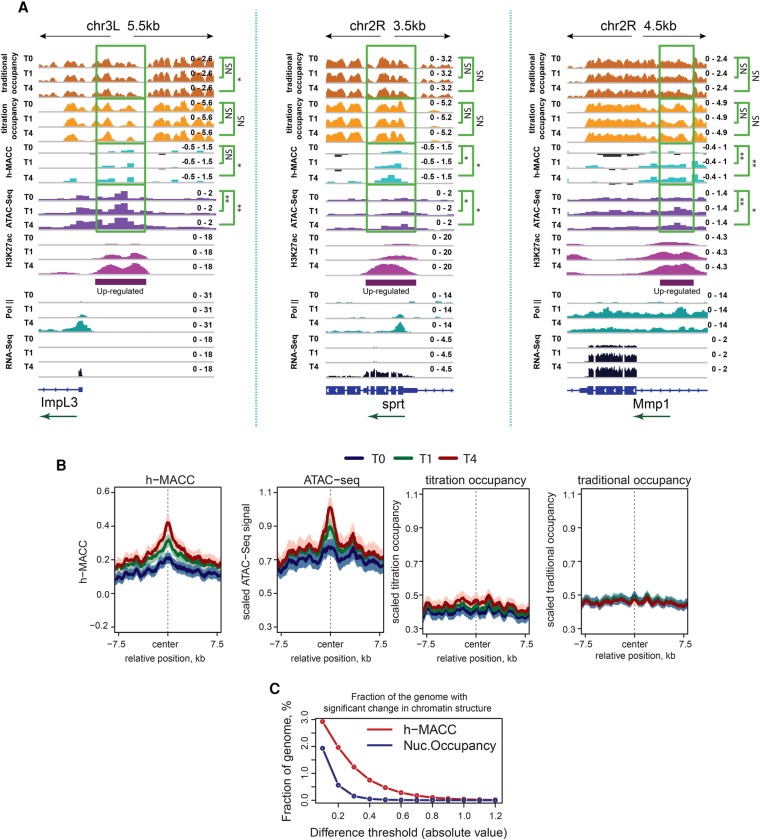
Chromatin organization at the gene-distal enhancers up-regulated in the UPR. (A) Profiles of nucleosome occupancy, h-MACC, ATAC-seq, H3K27ac, RNA Pol II, and RNA-seq around up-regulated enhancers. The top panels show nonbinned nucleosome occupancy profiles together with the h-MACC profile around the identified enhancers. P-values were estimated with one-sided signed rank test (see the legends for Figs. 1C and 2 for more detail). (B, from left to right) Average profiles of chromatin accessibility (h-MACC) and scaled profiles of ATAC-seq, titration occupancy, and traditional occupancy around up-regulated enhancers. See the legend for Figure 3A for more details. (C) Percentages of the genome that exhibit significant changes in either h-MACC or titration occupancy. The Y-axis corresponds to the percentage, and the X-axis corresponds to different thresholds. (Red line) Changes in h-MACC; (blue line) changes in titration occupancy.